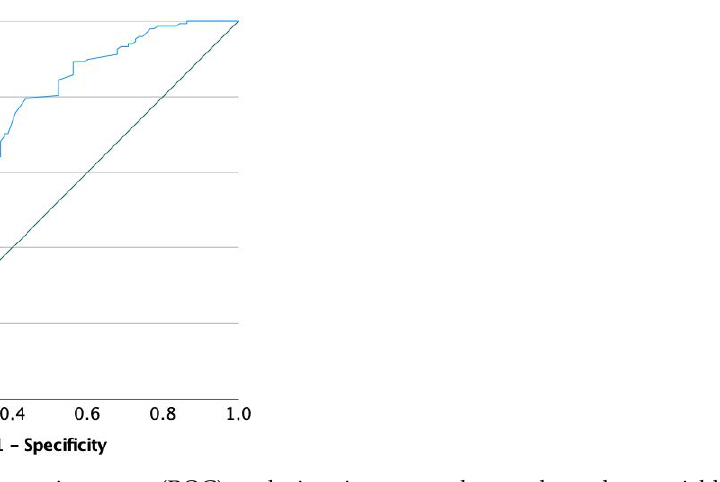
Figure 1. Receiver operating curve (ROC) analysis using responders as dependent variable and sperm DNA fragmentation (sDF) index as test variable.